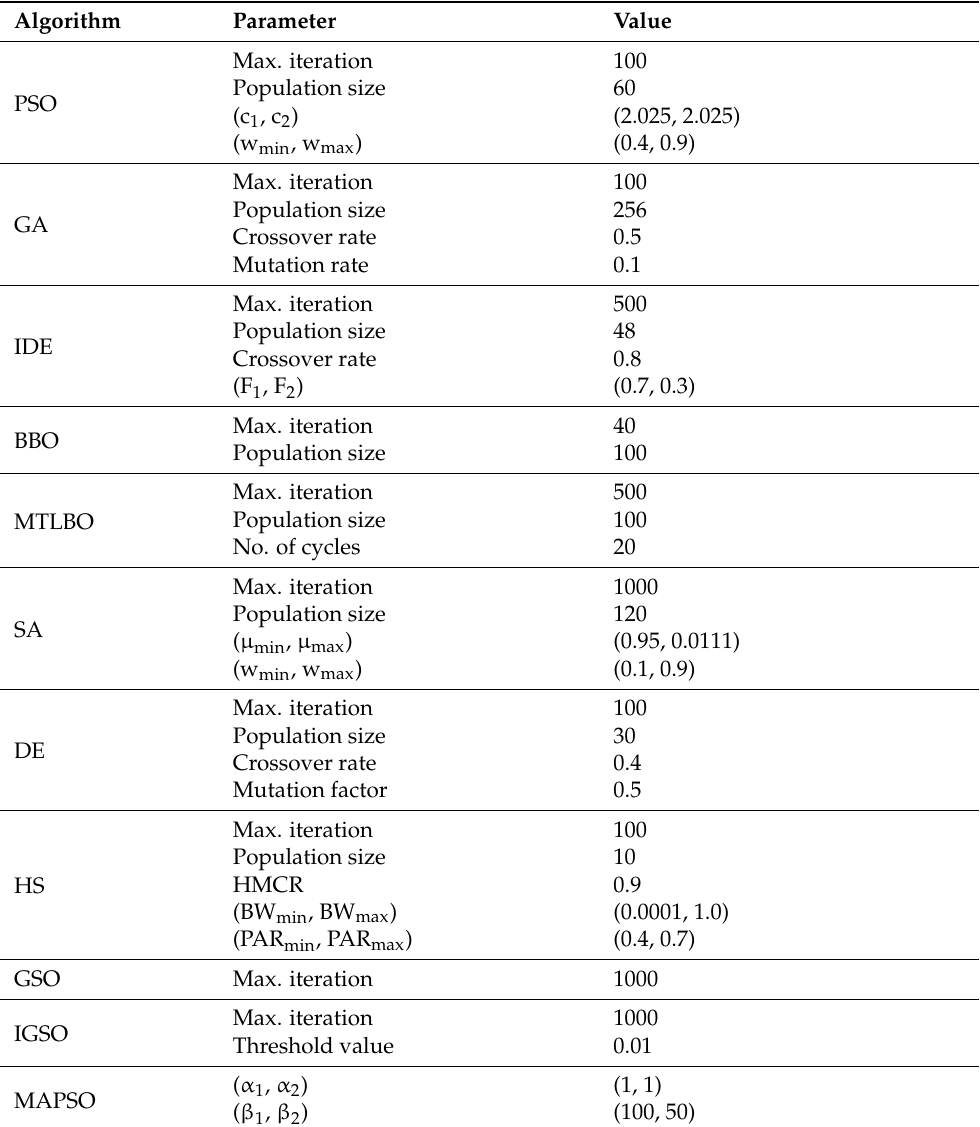
Table A1. Parameters of the